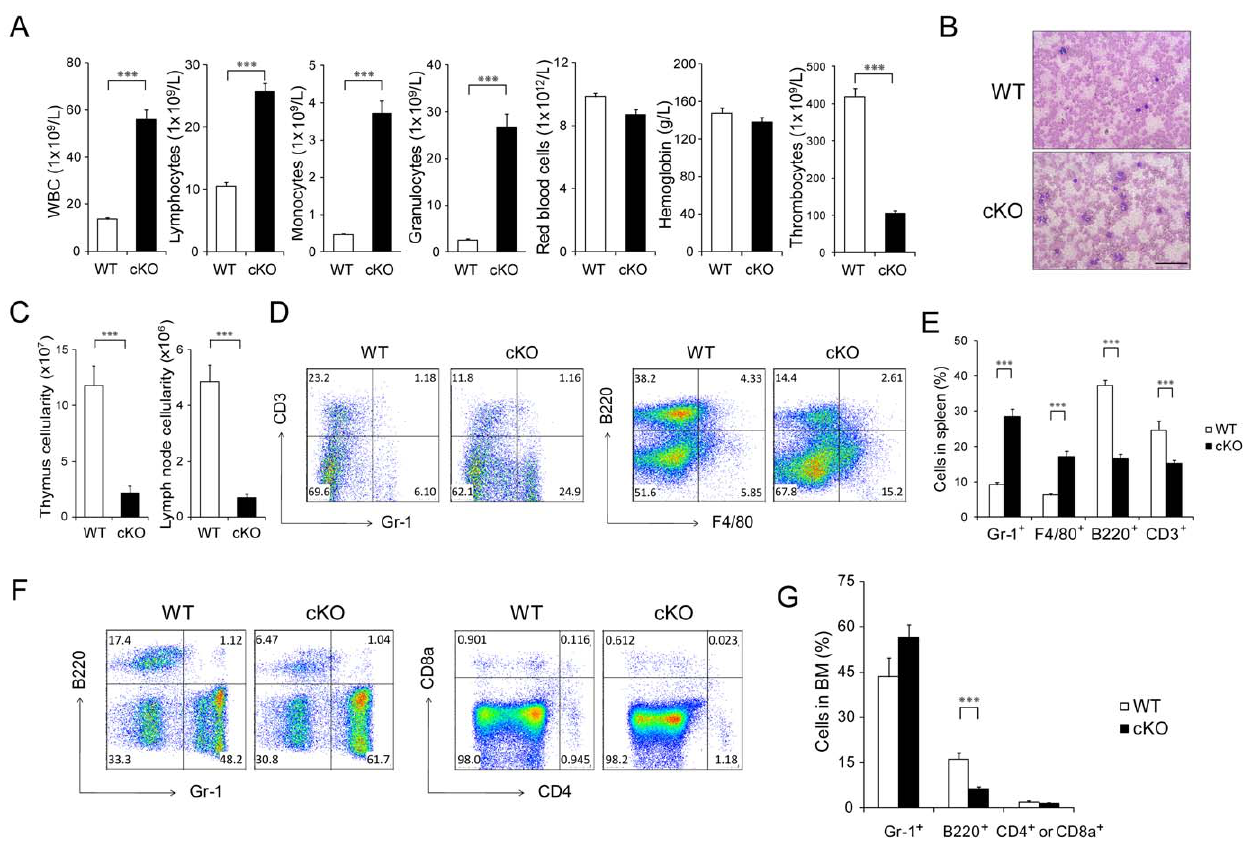
Figure 11. Grp94 KO mice displayed altered myeloid and lymphoid differentiation. A). Complete blood count of peripheral blood from WT (n=31) and cKO (n=37) mice. B) Representative Wright-Giemsa staining of blood smear with tail peripheral blood from WT and cKO mice. Scale bar represents 500 m m. C) Total thymus cell number (left) and total left and right axillary lymph nodes cell number (right) from WT and cKO mice (n=7 for each group). D) Representative flow cytometric analysis of splenocytes from WT and cKO mice using lineage markers Gr-1 and CD3 (left), F4/80 and B220 (right). E) Quantitation of (D) from WT (n=4) and cKO (n=7) mice. F) Representative flow cytometric analysis with BM cells using lineage markers Gr-1 and B220 (left) and CD4 and CD8a (right). G) Quantitation of (F). Gr-1 and B220 (n=7 for WT and n=9 for cKO mice); CD4 and